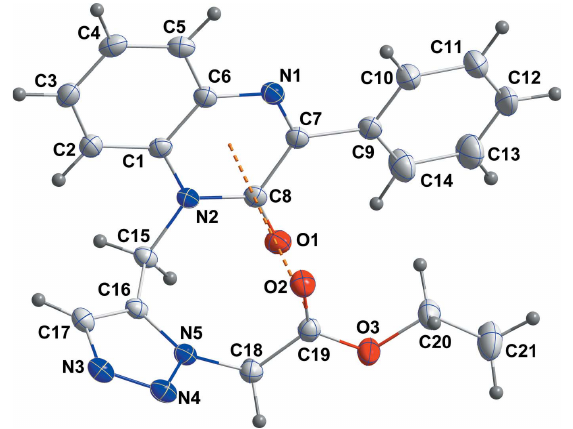
Figure 1 The title molecule with the labeling scheme and 50% probability ellipsoids. The (cid:2) interaction between the C19 O2 carbonyl group and the C1/C6/N1/C7/C8/N2 ring is shown by an orange dashed line.